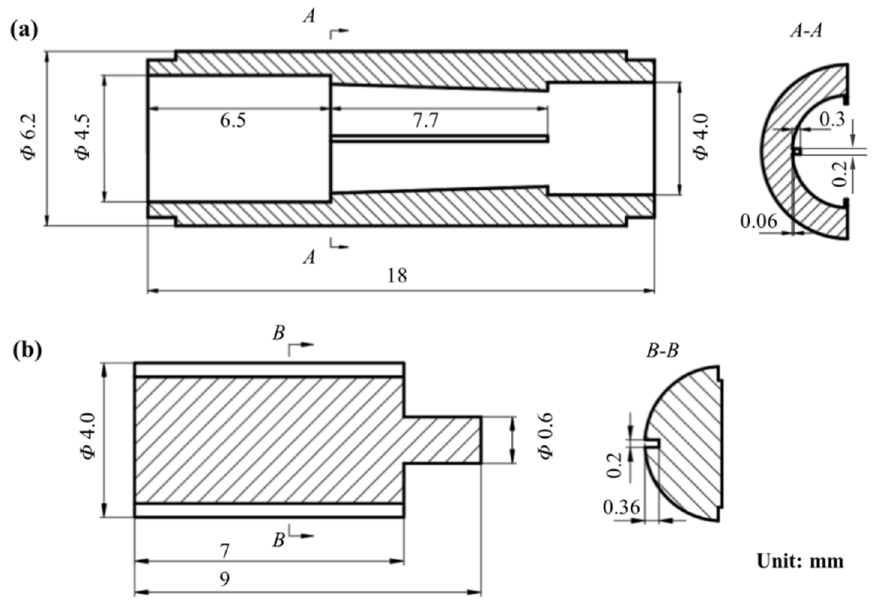
Figure 3. Main structure parameters of the MPV: ( a ) valve body; ( b ) valve core.